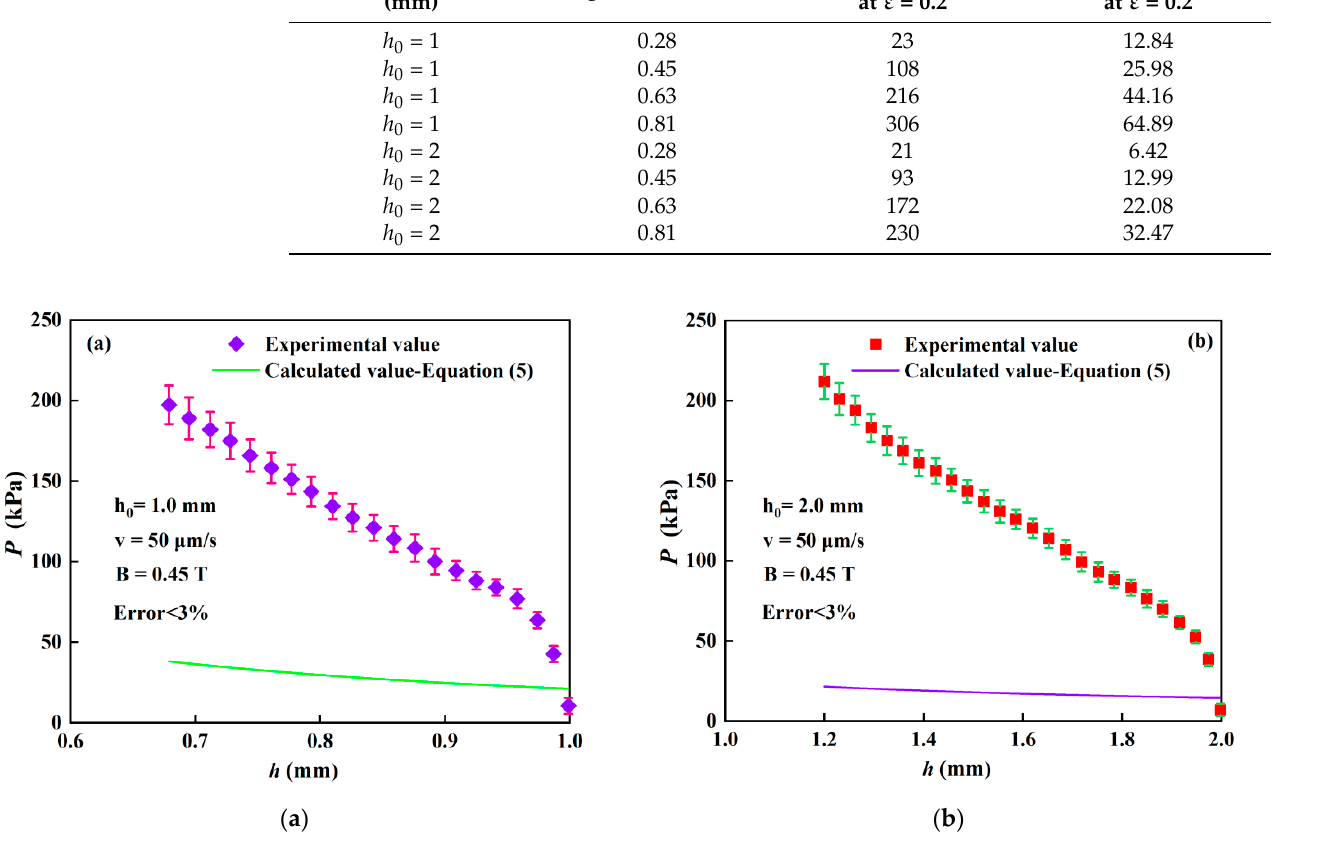
Figure 6. Comparison of compressive stresses between the measured and calculated results. ( a ) h 0 = 1 mm; ( b ) h 0 = 2 mm.